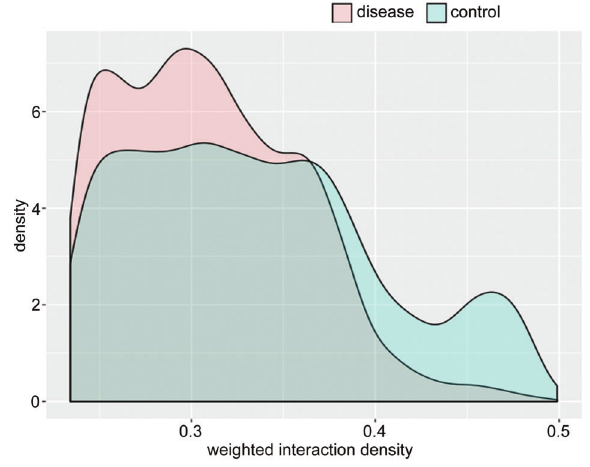
Functional analysis of genes in attractor modules